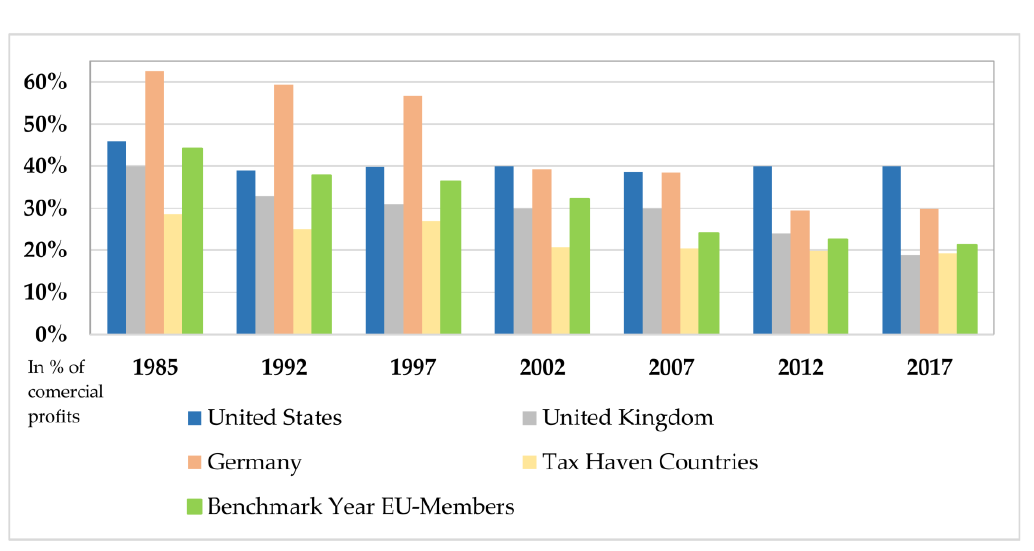
Figure A1. Corporate Tax Levels of Selected Countries. Source: Mintz and Weichenrieder (2010) (timeframe 1985–2008) and from KPMG (timeframe 2003–2017).